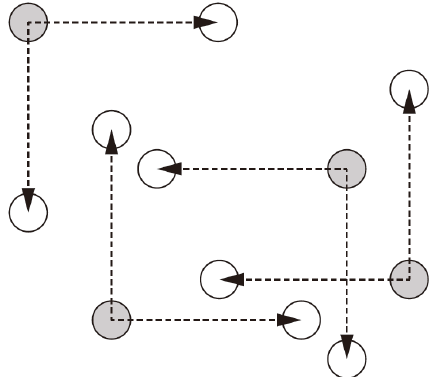
Fig. 9. Initial positions of ant agents in the ¯eld with vectors indicate the imaginary positions where they want their neighbors